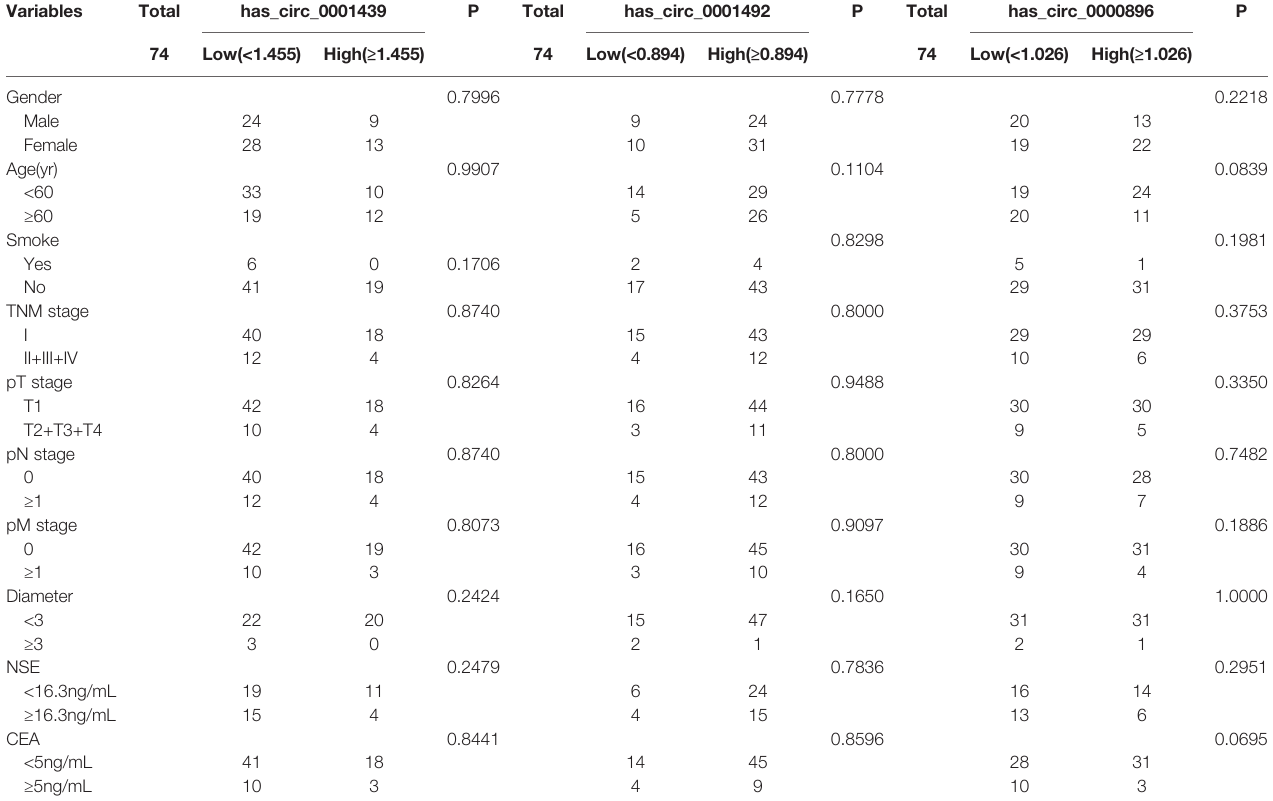
TABLE 2 | The correlation of serum hsa_circ_0001439, hsa_circ_0001492, and hsa_circ_0000896 expression levels with clinicopathological factors.